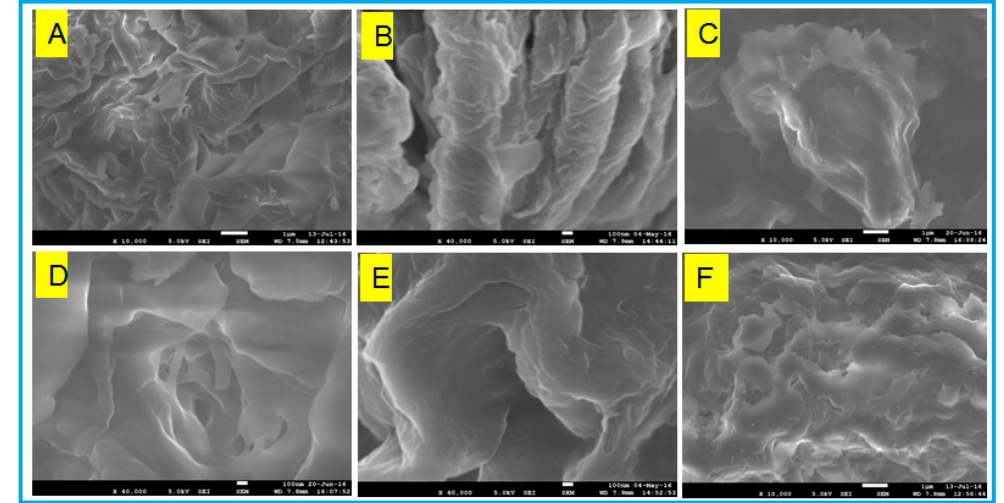
Figure 4. SEM images of xerogels of Gluconosemicarbazide gelator in DMSO/water mixture at a concentration of 30 mg/mL under different stimuli: ( A ) thermally-induced (1 µm); ( B ) SDS (100 nm); ( C ) KCl (1 µm); ( D ) NaCl (100 nm); ( E ) CaCl 2 (100 nm); ( F ) ultrasound-induced (1 µm).